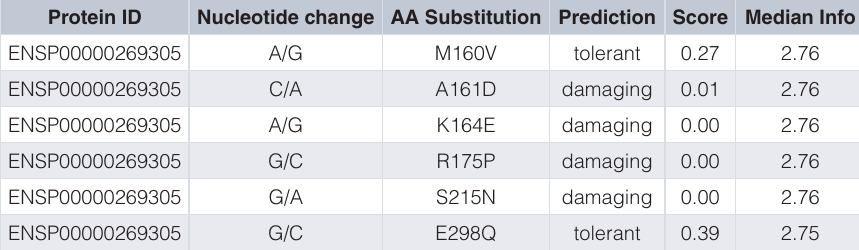
Table 3. List of variants that were analyzed using SIFT algorithm.